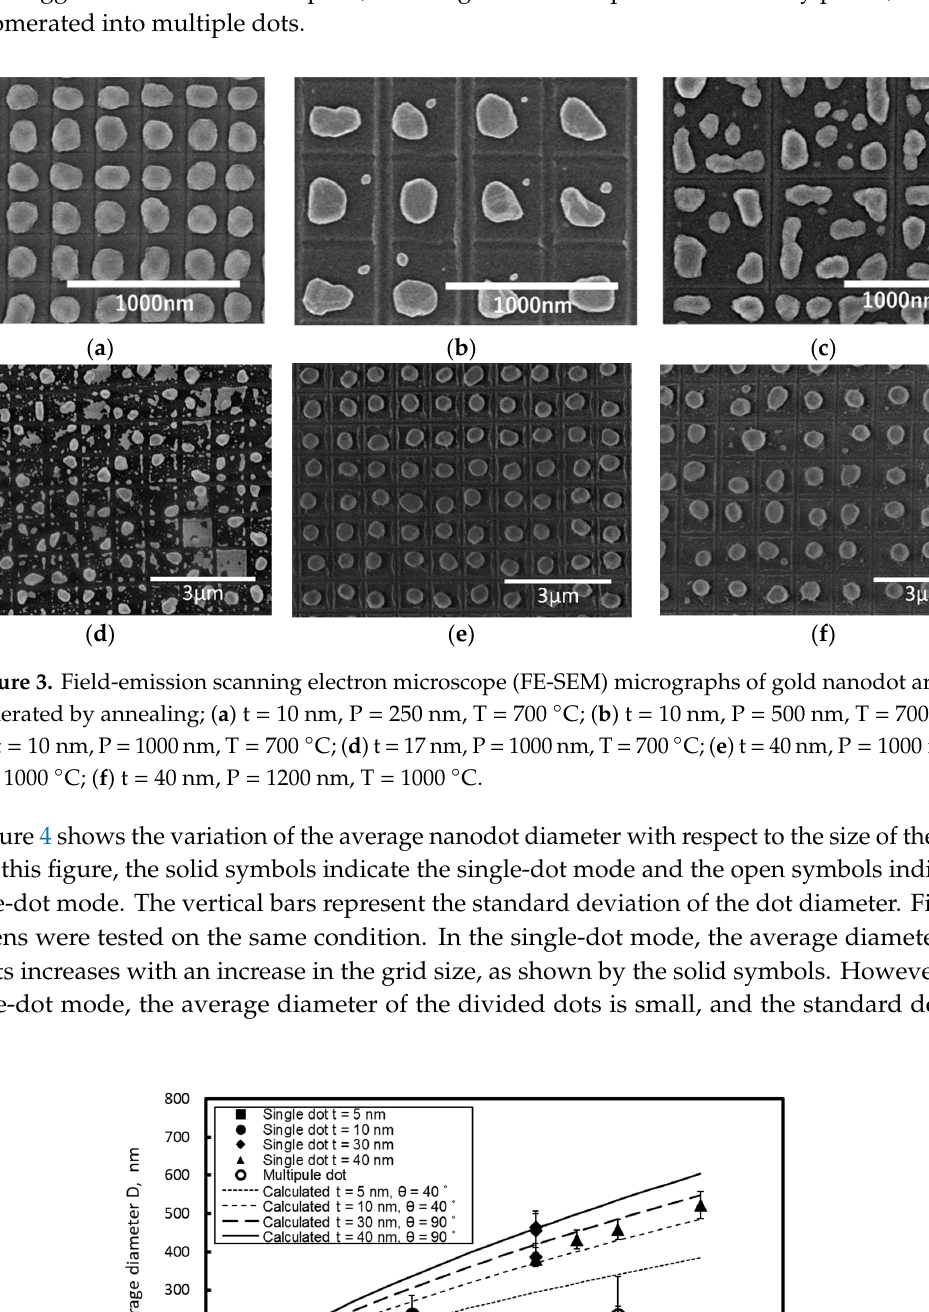
(3) Figure 5. Geometrical change of a nanodot by thermal dewetting. The curves in Figure 4 represent variations in D calculated by Equation (1). In this equation the dot diameter depends on the grid size and the contact angle; dot diameter becomes larger when the contact angle becomes smaller. In Figure 4, the contact angles were adjusted so that the calculated curves agreed with the experimental data: the contact angle θ c = 40° when t = 5 nm and t = 10 nm ( T = 700 °C), and the contact angle θ c = 90° at t = 30 nm ( T = 1000 °C). It is confirmed that the model explains variation of the nanodot diameter of single mode well. Although this calculation model assumes that all nanodots are agglomerated into a hemispherical form with equal contact angles, the actual nanodots are distorted as seen in Figure 2, and the contact angles varies along the circumference of a dot. Thus, the calculated contact angles do not represent the correct contact angles. However, the contact angles of 40° and 90° determined from the curve fitting can be considered representing the average contact angle of actual nanodots, including some 10° of error. Difference between the contact angles of both conditions is attributed to the difference in the annealing temperature. Because thermal dewetting is attributed to atomic diffusion, and the diffusion coefficient depends on temperature, the agglomeration rate increases with annealing